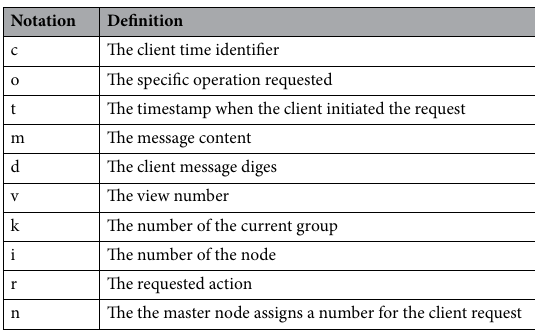
Table 2. Frequently used notation.